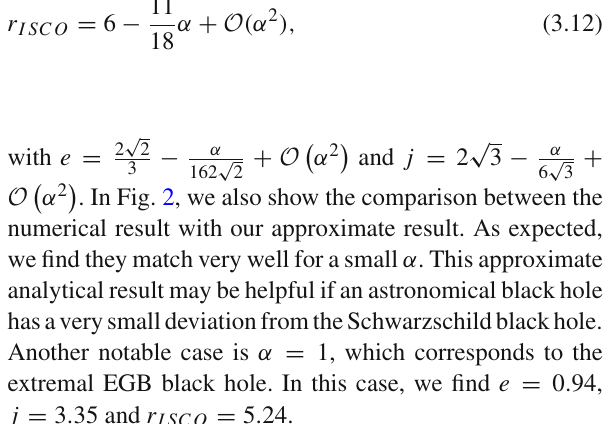
is the comparison of numerical result of ISCO radius with the approxi- mate one (3.12), where the orange line denotes the approximate result and the blue one denotes the numerical result